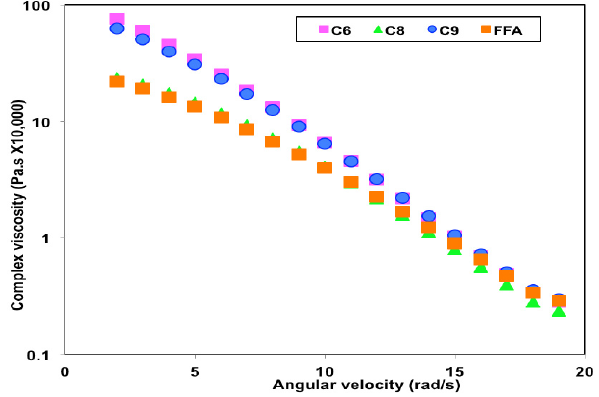
Figure 9. Complex viscosity of PHA polymers synthesized by P. putida LS46123 grown on: C6, Hexanoic acid; C8, Octanoic acid; C9, Nonanoic acid; and FFA, biodiesel ‐ derived free fatty acids (REG ‐ FFA).